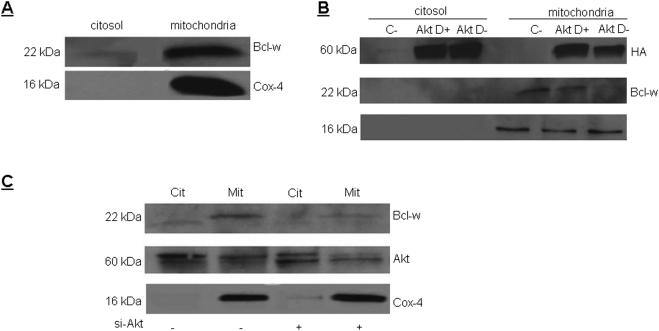
Akt controls Bcl-w localization.(A) HeLa cells were subjected to fractionated separation of mitochondrial/cytosolic proteins using a mitochondria/cytosol fractionation kit (Biovision). Protein extracts were loaded onto 15% SDS polyacrilamide gel, and analyzed by western blot by anti-Bcl-w antibody. As a control of the mitochondrial fraction, an anti-cox4 antibody was used. (B) HeLa cells were transfected with 2 µg of HA-Akt WT, D+, or D− for 48 hrs. Cells were subjected to mitochondria/cytosol separation as above. Protein extracts were analyzed by western blot using anti-Bcl-w, anti-Akt, or anti-cox4 antibodies. (C) Cells were transfected with 100 nM of siAkt-RNA for 48 hrs. Cytosol and mitochondria were isolated as described in the methods and analyzed by western blot using the indicated antibodies.